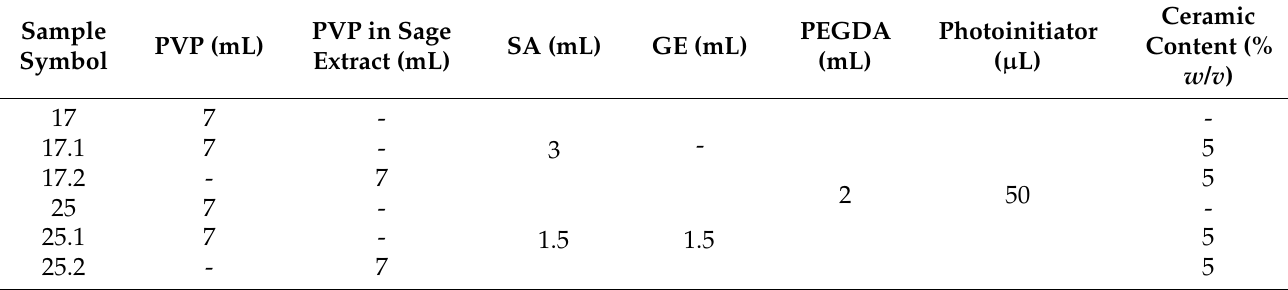
Table 1. Composite materials